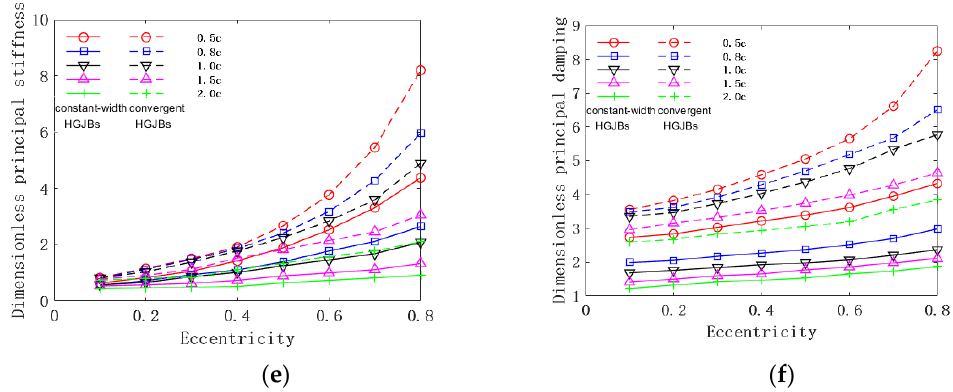
Figure 18. The influence of groove depth on the performance of HGJBs: ( a ) Dimensionless load capacity ( b ) Side leakage ( c ) Dimensionless friction power ( d ) Average temperature rise ( e ) Dimensionless principal stiffness ( f ) Dimensionless principal damping.